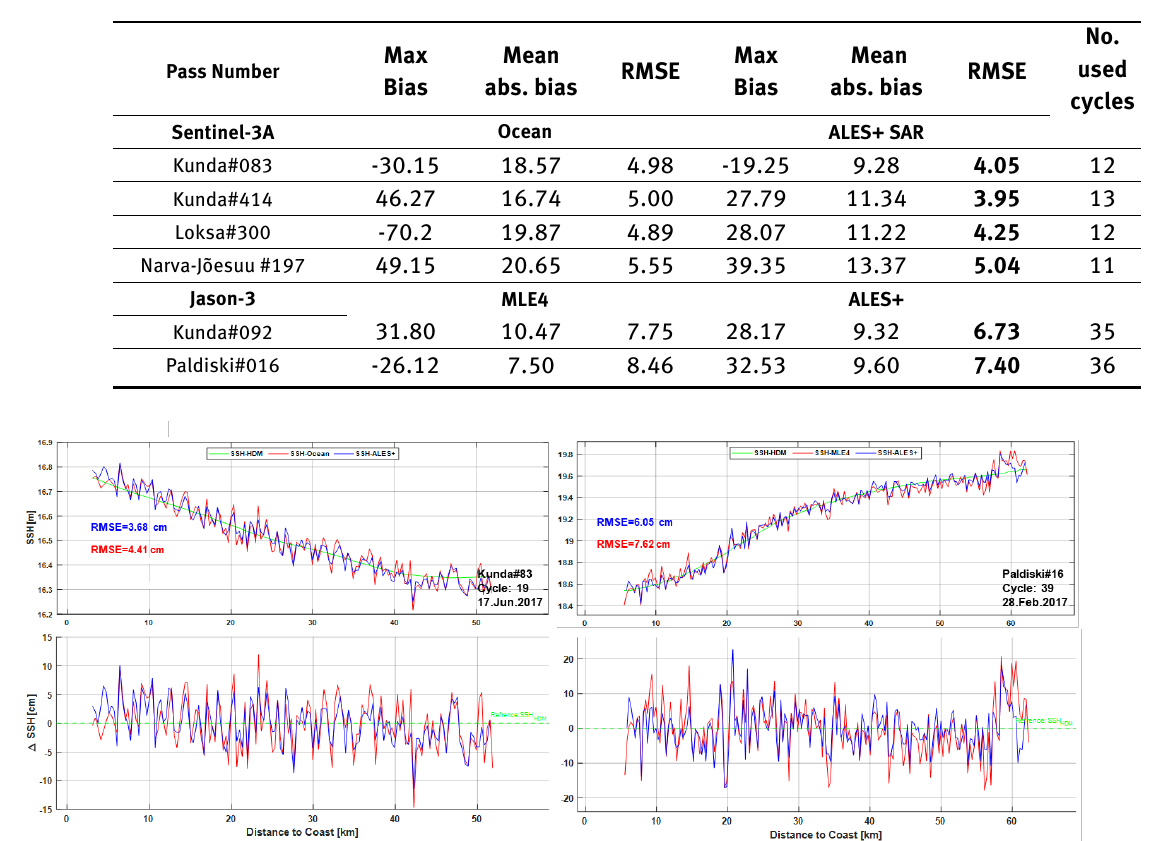
Table 4: Statistical estimates of post-fit residuals ∆ SSH [cm] for SA and HBM along track SSH for both S3A and JA3 (better performances are emphasised in the bold digits)